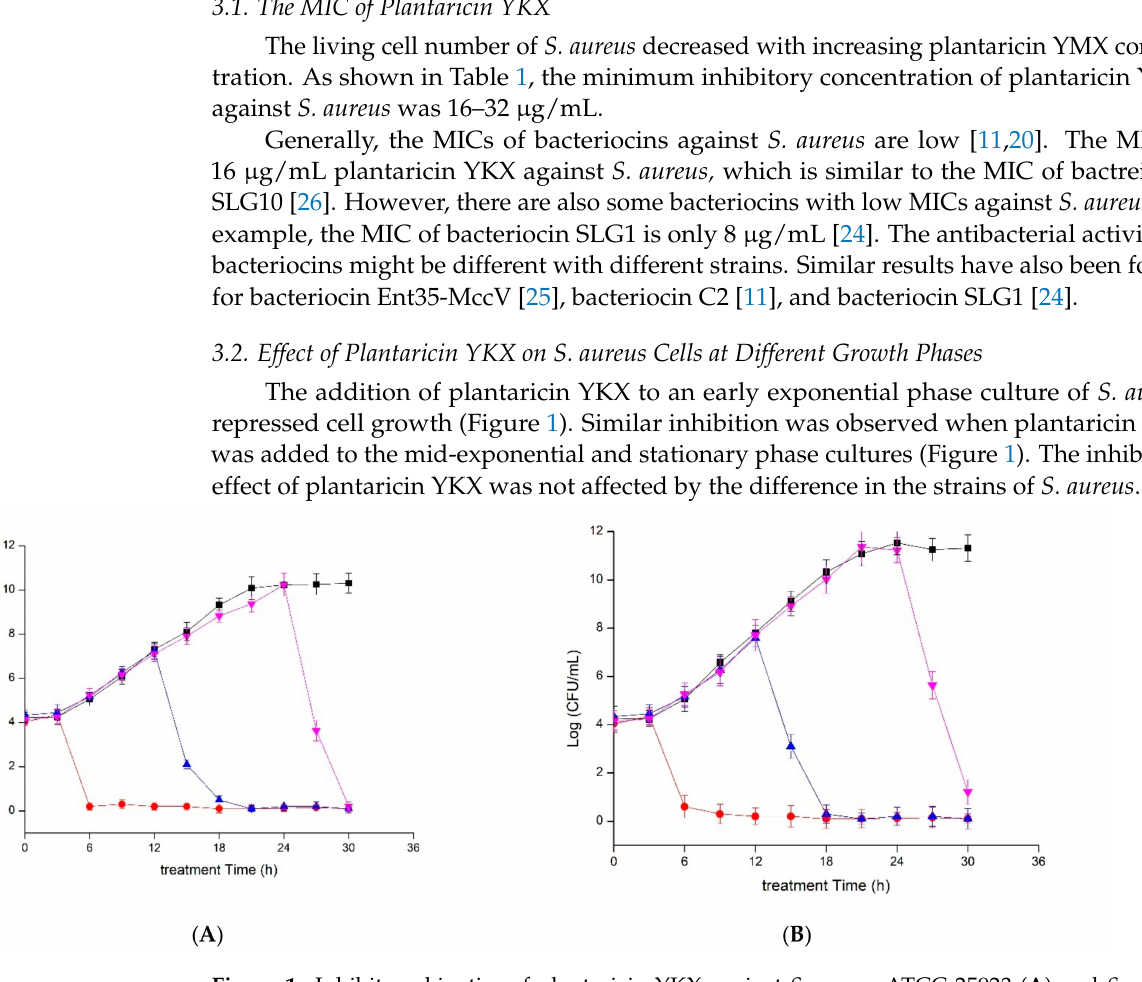
Figure 1. Inhibitory kinetics of plantaricin YKX against S. aureus ATCC 25923 ( A ) and S. aureus CMCC 26570 ( B ). ( (cid:4) ): Control (without plantaricin YKX treatment); plantaricin YKX was added at